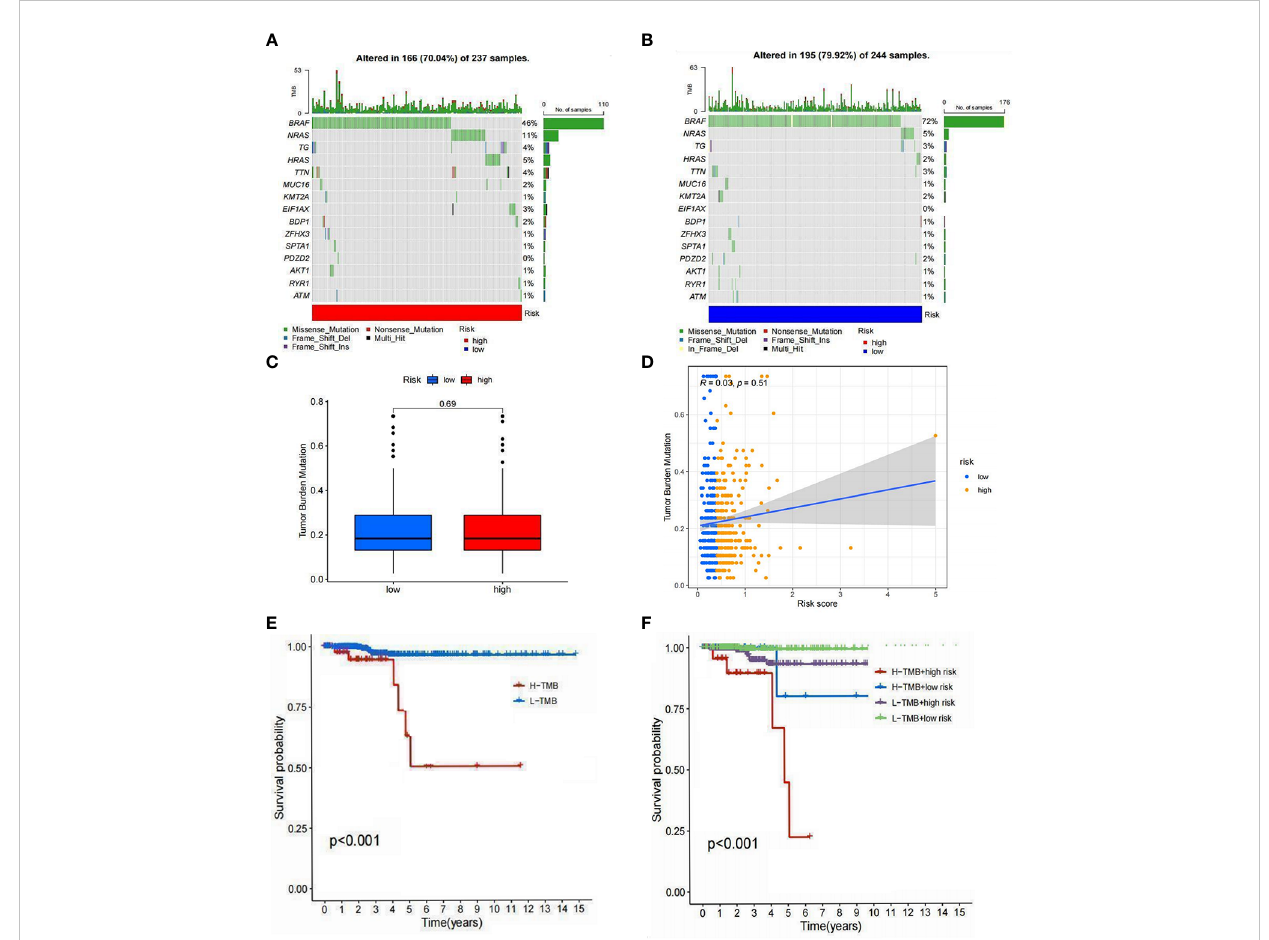
FIGURE 10 Tumor mutation analysis. (A) The 15 mutations were identi fi ed in the high-risk group. (B) The 15 mutations were identi fi ed in the low-risk group. (C) Differences in the TMB of high- and low-risk groups. (D) Relationship between risk scores and TMB. (E) Differences in survival between the high TMB and low TMB groups. (F) Differences in survival between high TMB with a low-risk score, high TMB with a high-risk score, low TMB with a low-risk score, and low TMB with a high-risk score (P<0.05 was considered signi fi